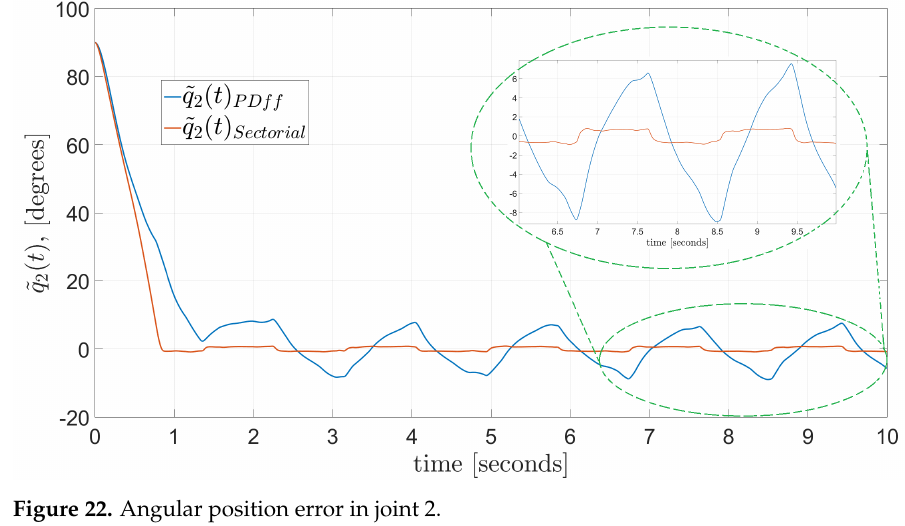
Figure 22. Angular position error in joint 2.